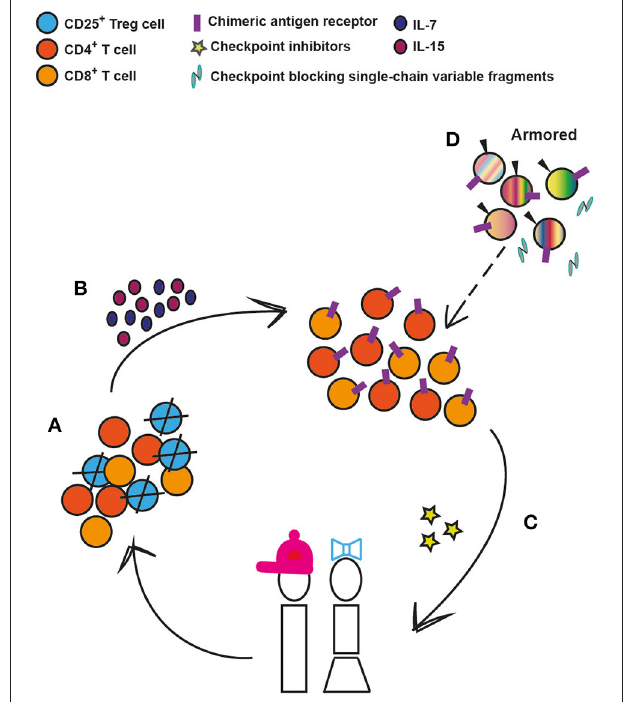
FIGURE 2 | Conceivable strategies to enhance CAR T-cell efficacy and persistence in pediatric ALL. (A) Depletion of regulatory T cells (Tregs) prior to chimeric antigen receptor engineering. (B) Provision of proliferation and survival factors for T cells. (C) CAR T cells can be co-administered with immunomodulatory agents such as check-point inhibitors that target PD-1 or CTLA-4 pathways. (D) Armored CAR T cells are genetically modified to, along with the CAR, secrete cytokines, such as Il-7, IL-12, and IL-15, or to express immunomodulatory ligands such as CD40L or to secrete PD-1 blocking antibodies. These 4th generation cells can in the future replace the earlier-generation CAR T cells (depicted by dashed